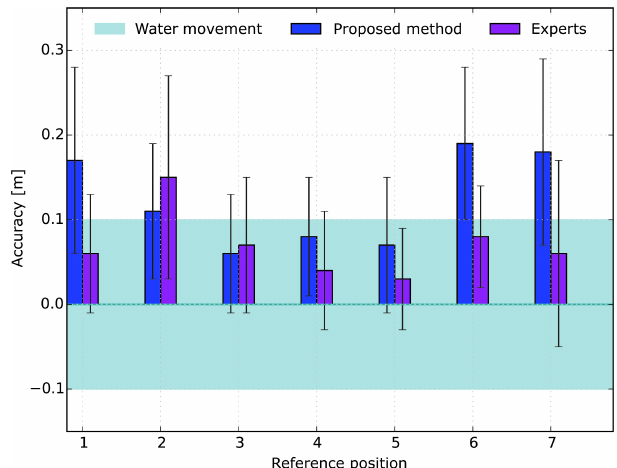
Figure 6. Derived inundation depth accuracy and precision of the proposed method (blue) and expert measurements (magenta) given in comparison to the water movement